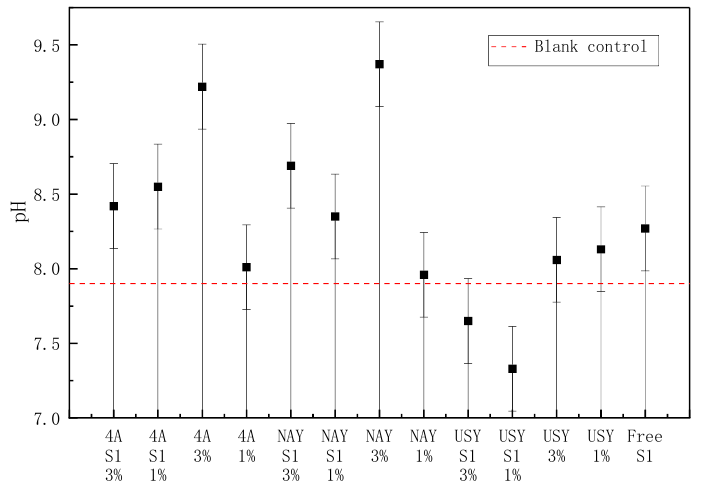
Figure 2. The effect of zeolite and bacteria on soil pH.